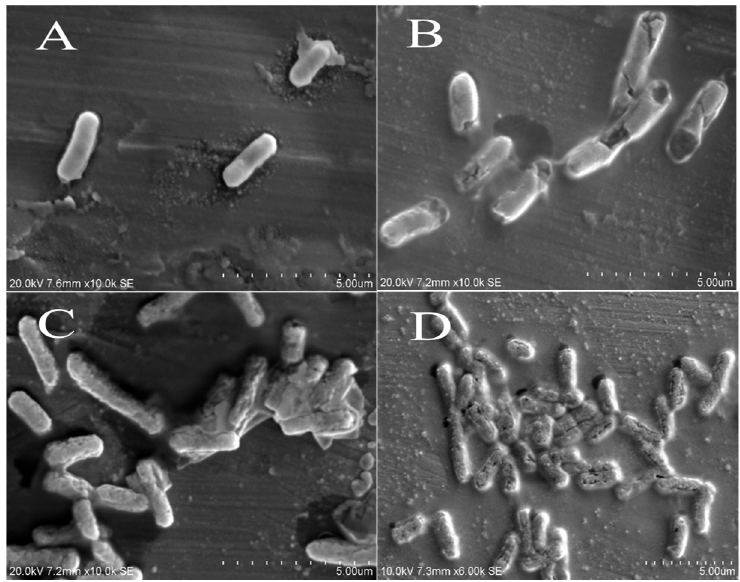
Figure 4. Scanning electron microscope imaging of untreated bacterial cells of ( A ) E. coli (clinical isolates); treated bacterial cells of E. coli (clinical isolate) with ( B ) leaves; ( C ) pods; ( D ) bark extracts of acacia.